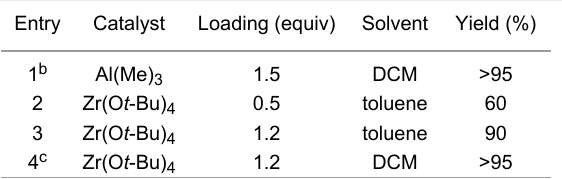
Table 2: Lewis acid catalysis of amidation of triazine 8a .